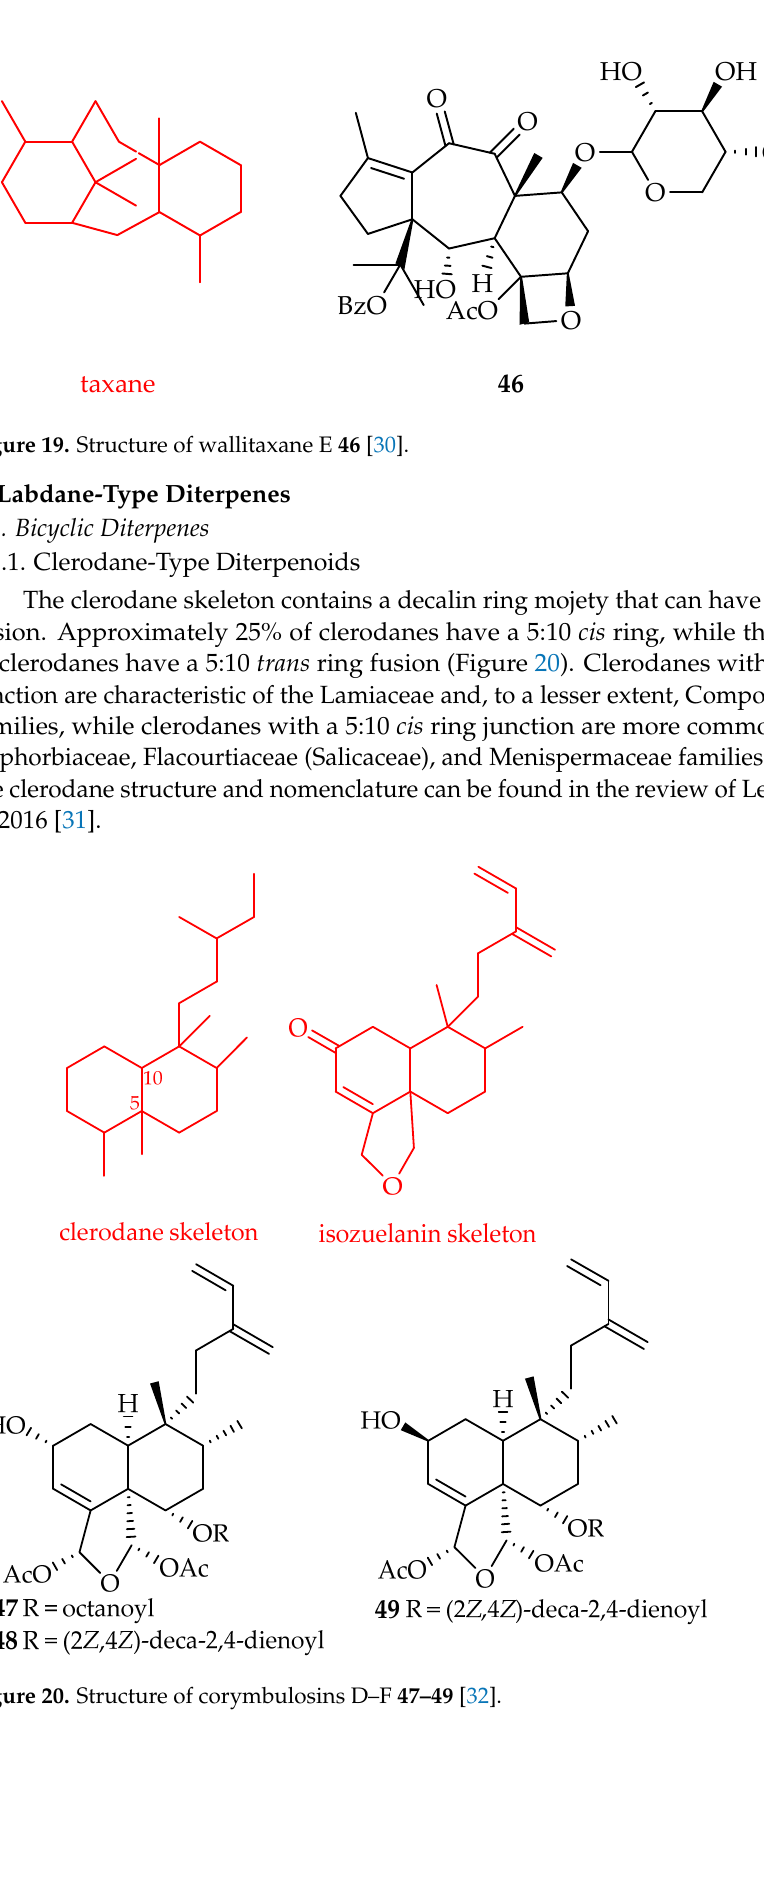
O Figure 18. Structures of crotonol A 44 [29] and crotonol B 45 [29]. 2.2.10. Taxane-Type Diterpenoids Nguyen et al. isolated six new taxoids, i.e., wallitaxanes A-F, from the bark of Taxus wallichiana (Taxaceae) by extraction with dichloromethane [30]. A detailed spectroscopic analysis was performed to assign the correct structure to the new compounds. All the isolated compounds were evaluated for cytotoxicity against the HeLa cell line and among